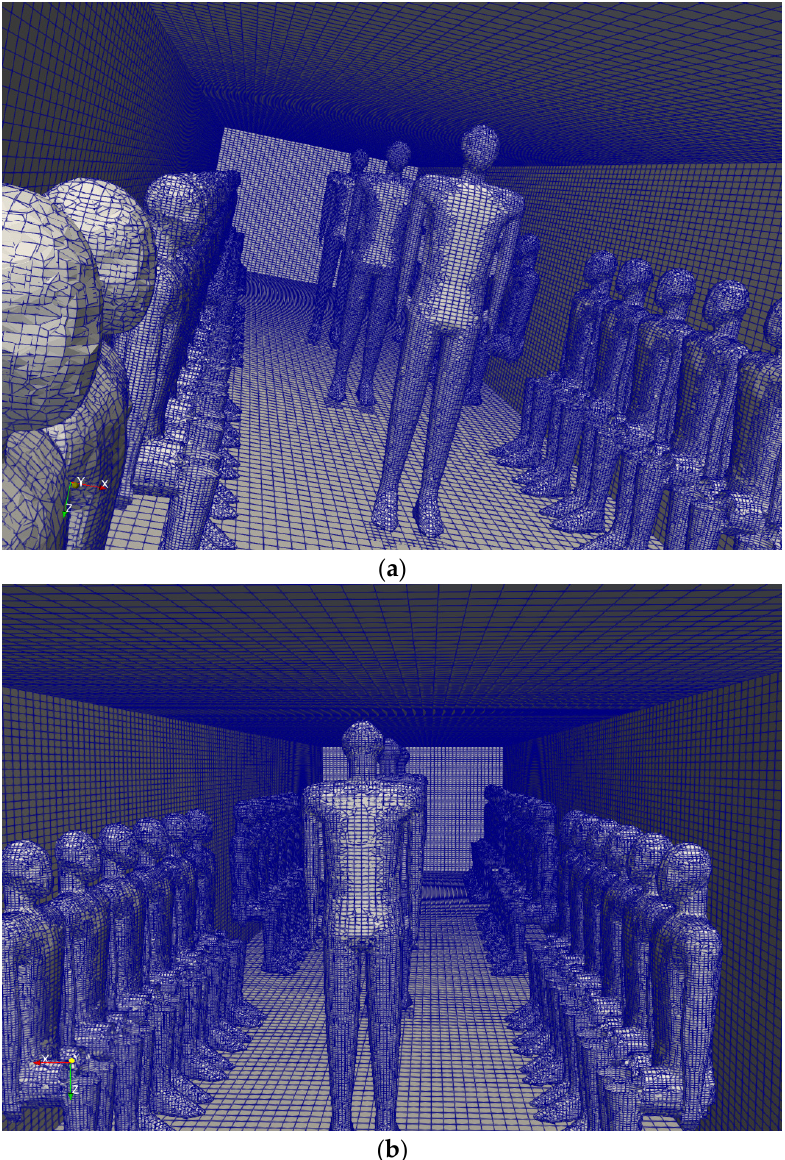
Figure 3. Schematic of mesh configuration for the present work. ( a , b ) are side views of urban sub- way fine mesh, ( c ) is the back view of fine mesh, and ( d ) is the front view of fine mesh.